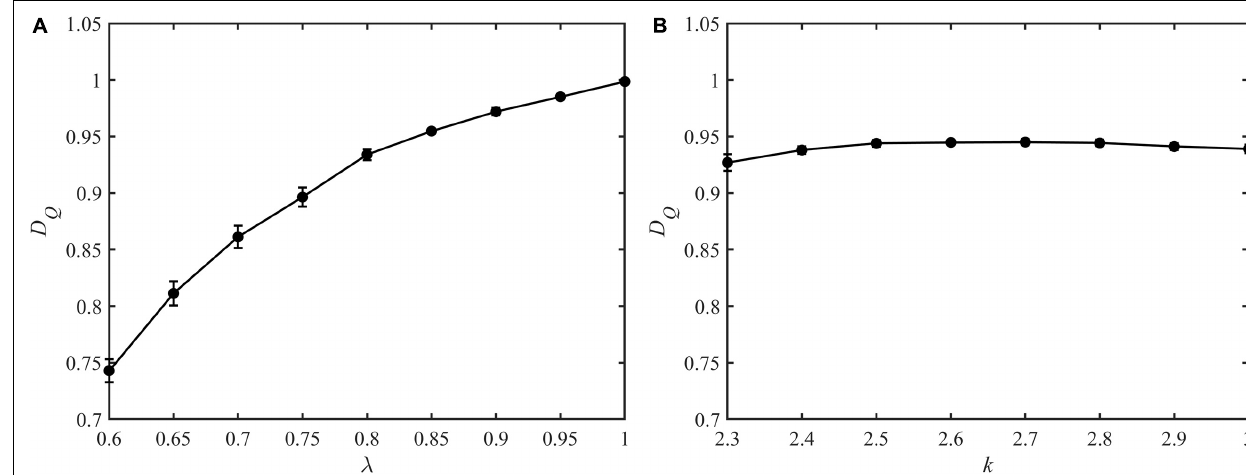
FIGURE 8 | The fractal dimension for blood flow of the vascular trees with varying λ (A) and k (B) .